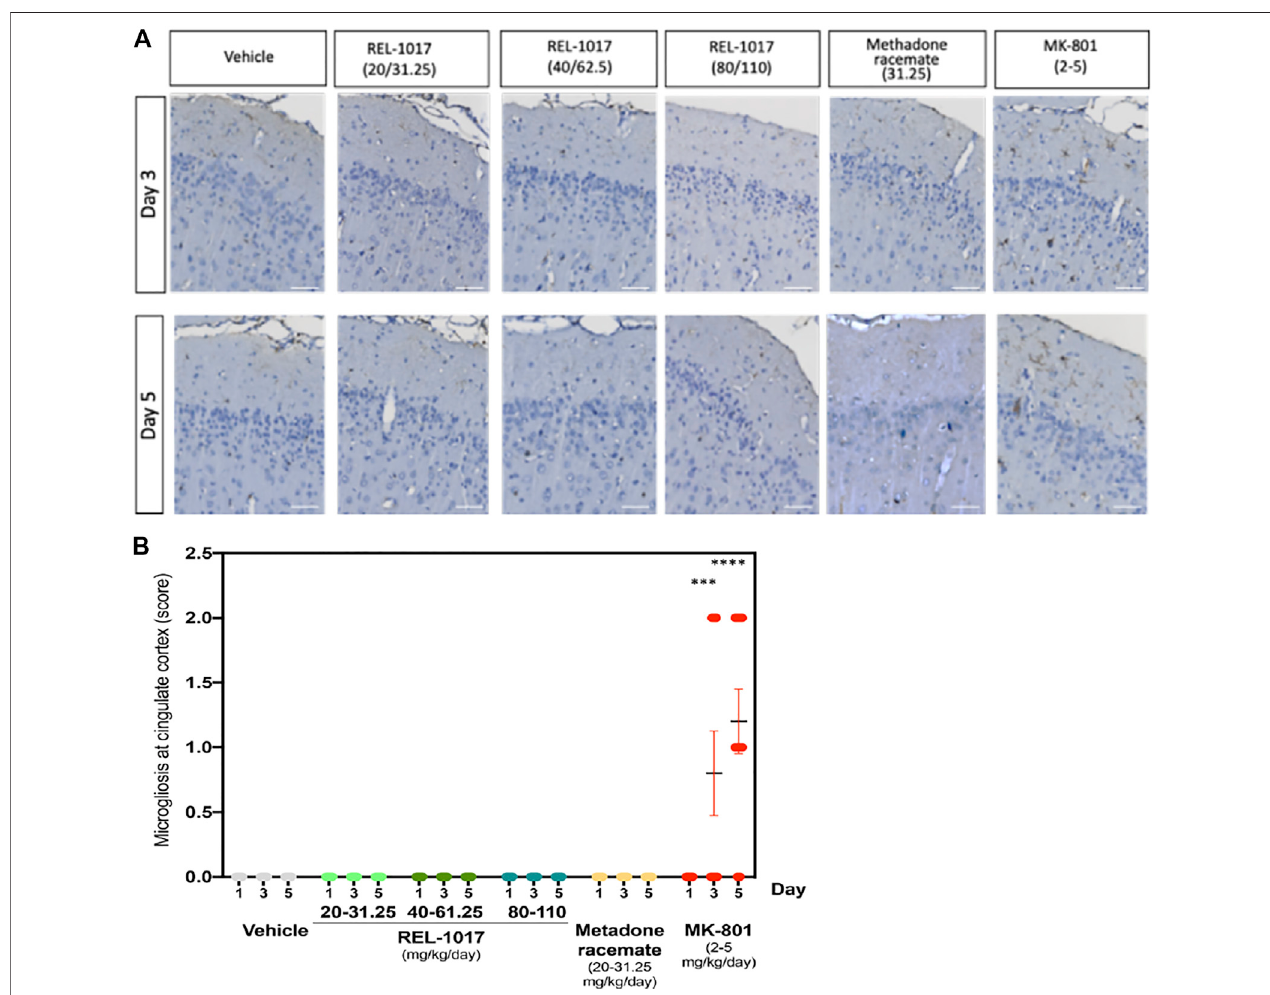
FIGURE 5 | Administration of REL-1017 did not cause microgliosis in the brain cingulate cortex. (A) Immunohistochemistry analysis of IBA1 positive (brown) microglial cells in the cingulate cortex at Day 3 and 5. MK-801 treated samples showed a clear increase in IBA1 positive (brown) microglial cells. (B) Quanti fi cation of microgliosis. The oral administration of REL-1017 at any dose (low, mid, and high) and of methadone racemate to both male and female Sprague-Dawley rats did not induce microgliosis ( p = ns versus all other groups). Statistical increase in microglia cell number, sored as mild microgliosis, were observed in animals treated with MK-801 at Day 3 ( p < 0.0001) and 5 ( p < 0.0001) compared to all the other